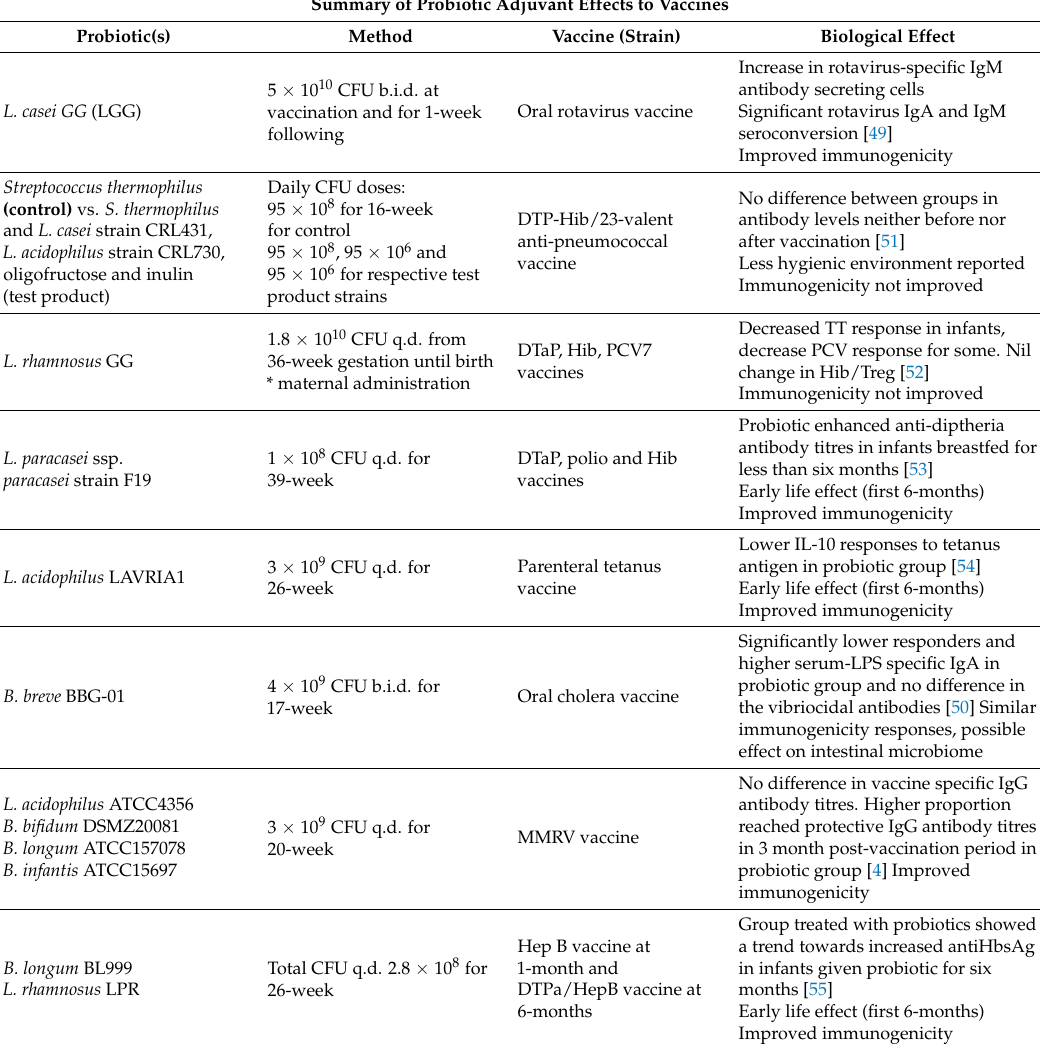
Table 1. Clinical studies investigating the effects of probiotics on vaccine responses in